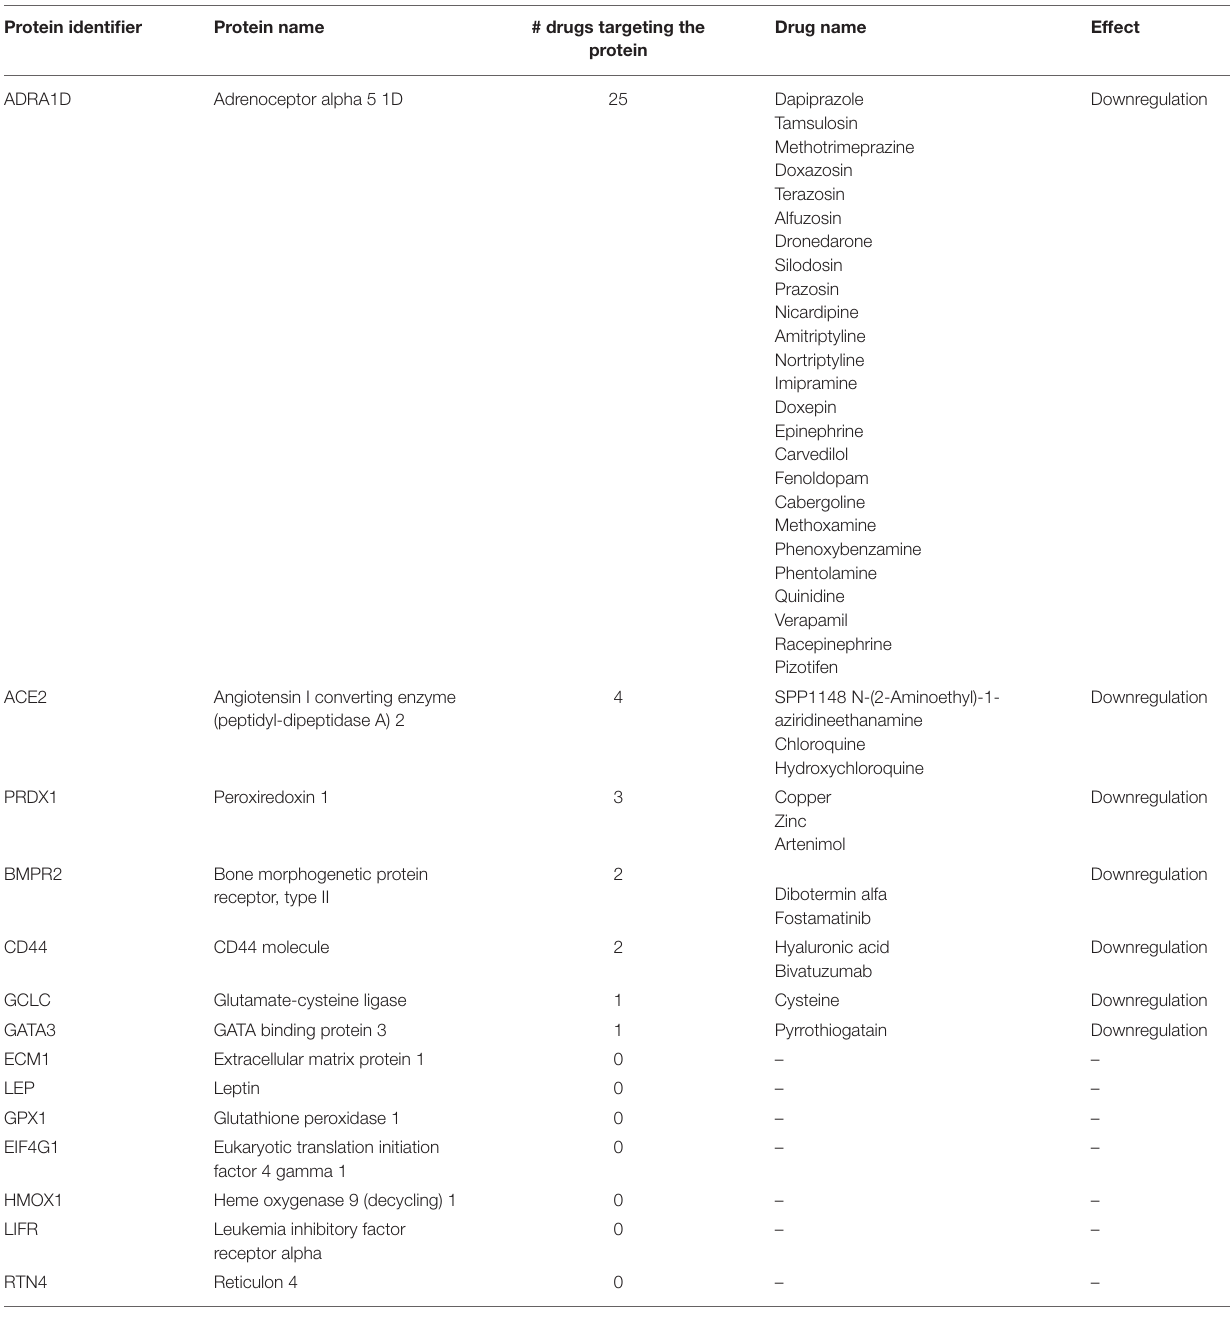
TABLE 1 | All drugs/compounds that target one or more of the proteins encoded by the 14 mRNAs candidates. Protein